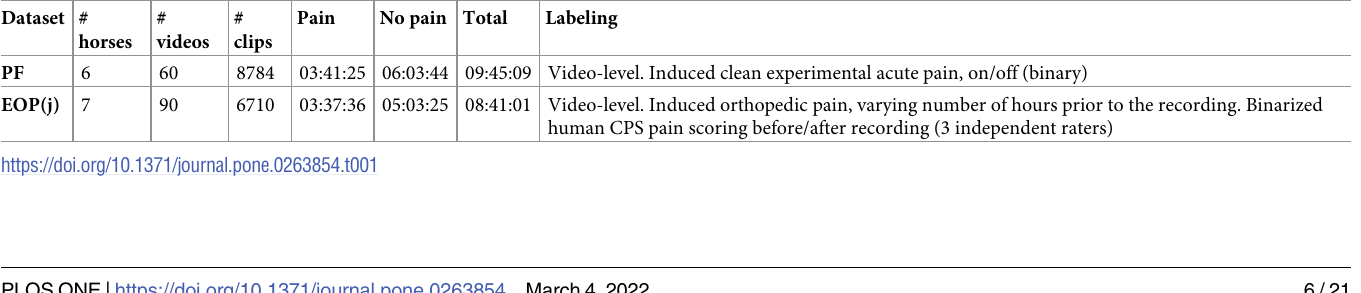
Table 1. Overview of the datasets. Frames are extracted at 2 fps, and clips consist of 10 frames. Duration shown in hh:mm:ss. Dataset # # # Pain No pain horses videos clips